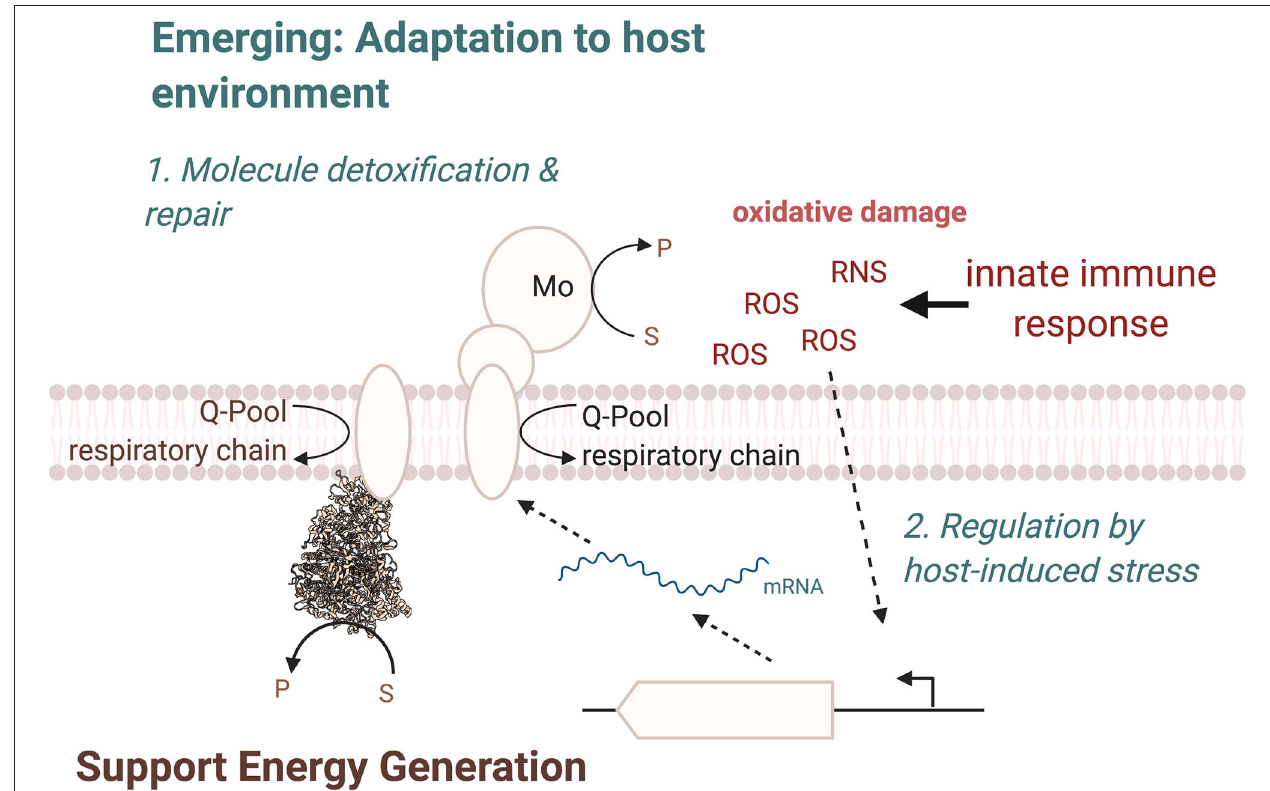
FIGURE 7 | Overview of cellular functions of Mo-enzymes in bacterial pathogens. The three main functions are in energy generation, enabling optimal use of the metabolic network, and the two emerging functions of converting substrates that only occur in the human host and changes in the enzyme regulatory circuits, where Mo-enzyme expression is induced by molecules produced by the host organisms during infection. ROS, Reactive Oxygen Species; RNS, Reactive Nitrogen